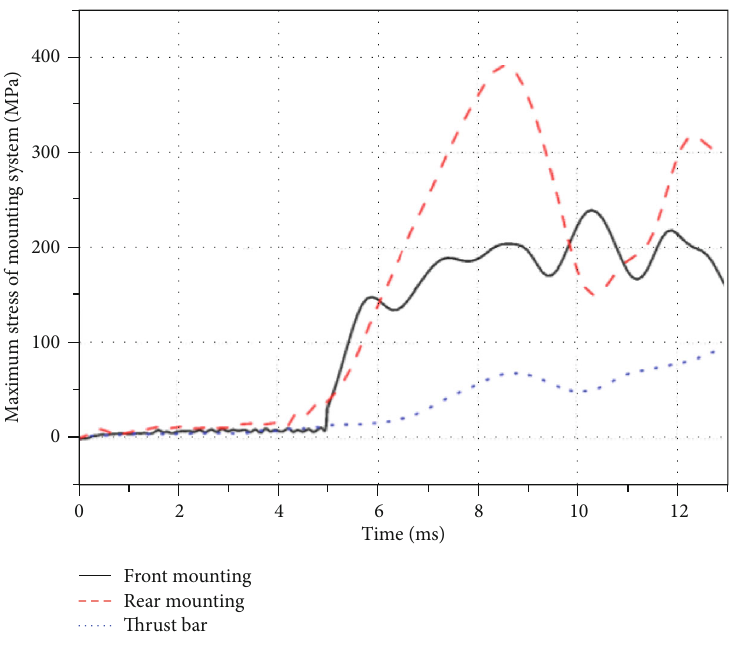
Figure 13: Stress variation of front mounting component.